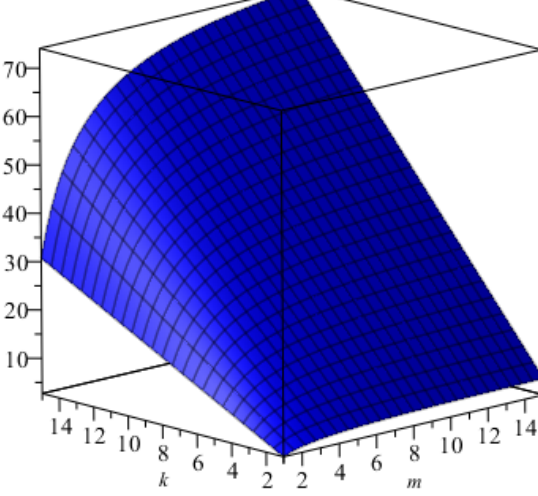
Figure 3. The graphically representation of the average eccentricity index avec of OX n .